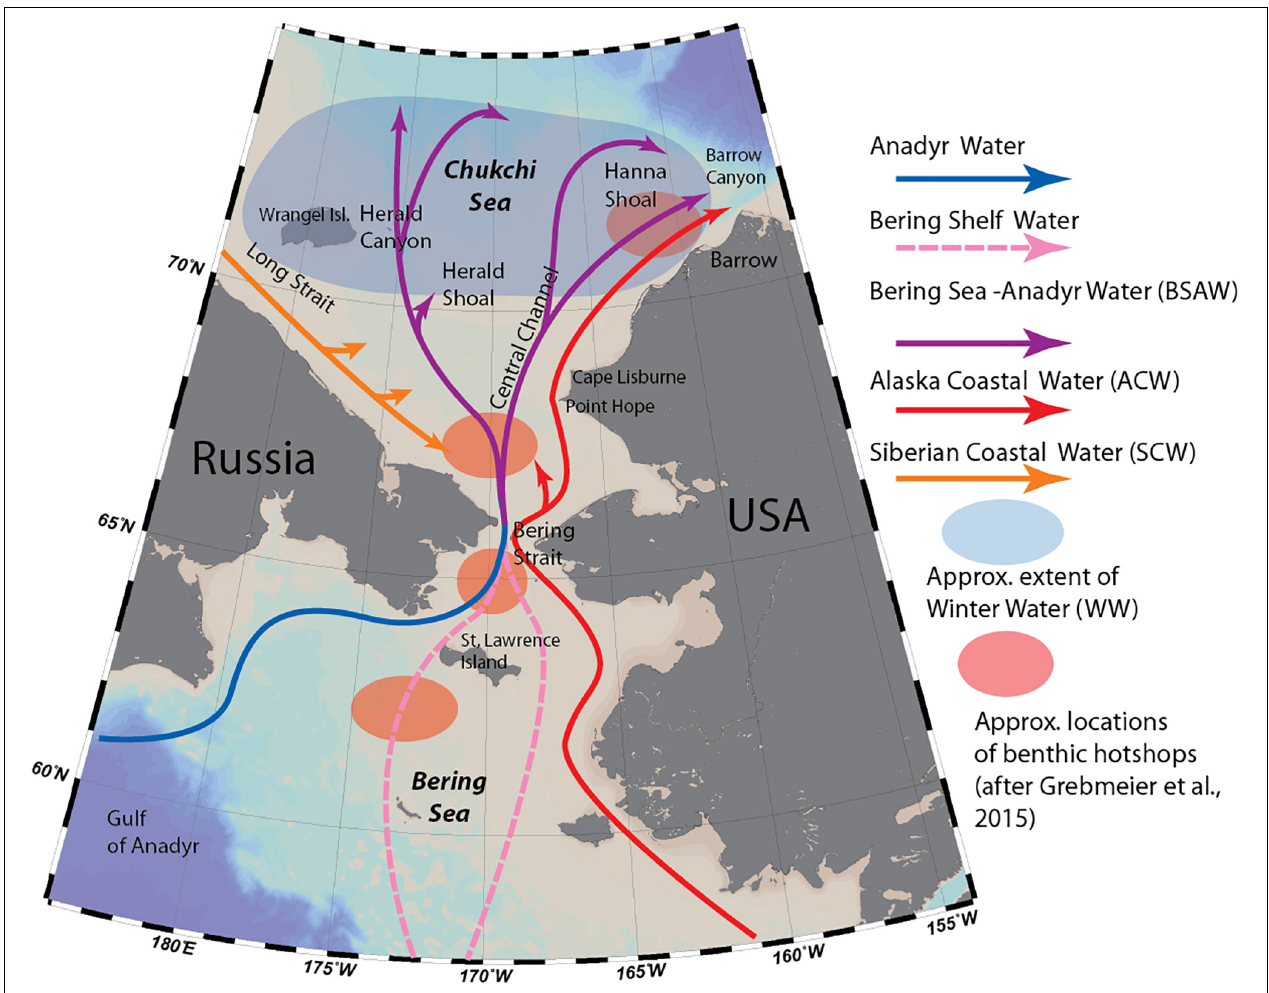
FIGURE 1 | Major oceanographic features of the Chukchi Sea (modified from Stabeno et al., 2018) and locations of macrobenthic hotspots as defined by Grebmeier et al.